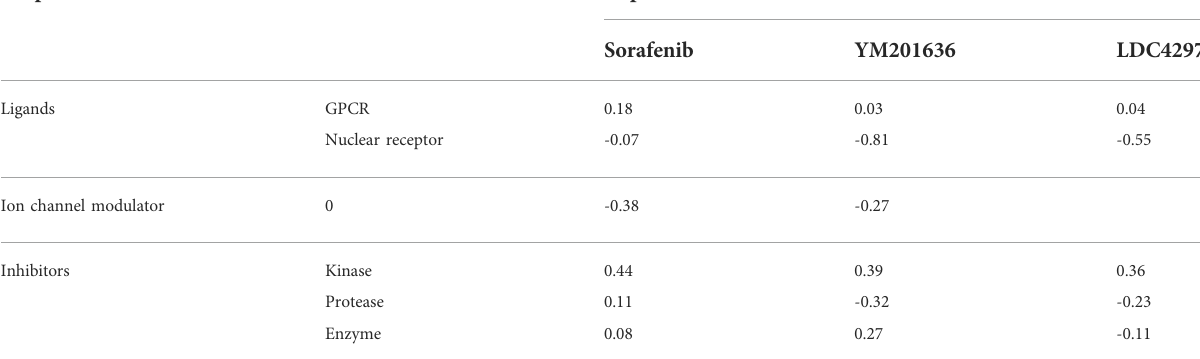
TABLE 2 Bioactivity score of top three